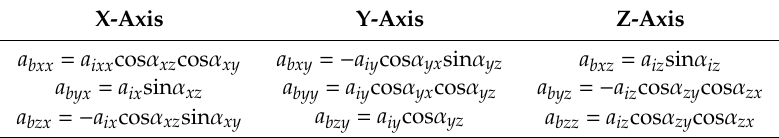
Figure 4. Schematic diagram of shaft declination. Table 1. Project of IMU measurement data on three axes.